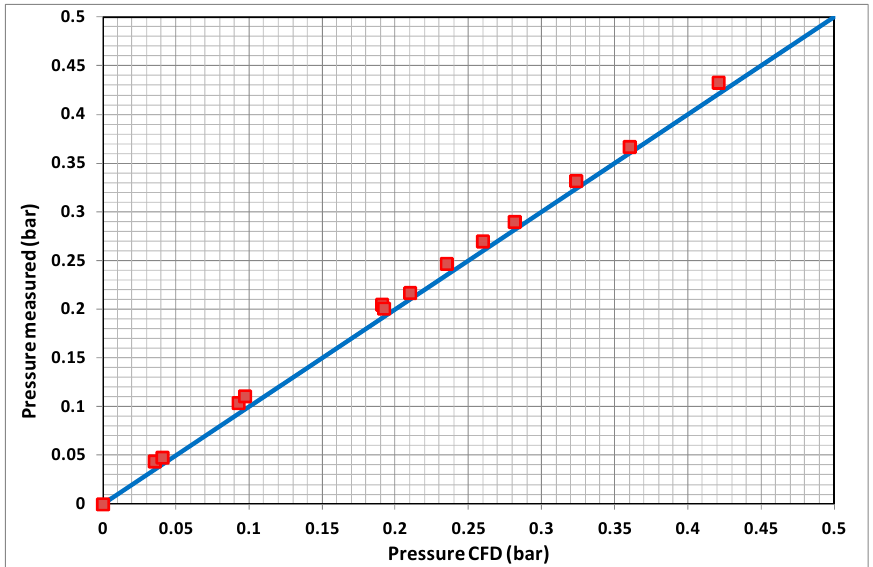
Figure 9. Comparison of the curve of an air valve: experimental data vs. CFD analysis.